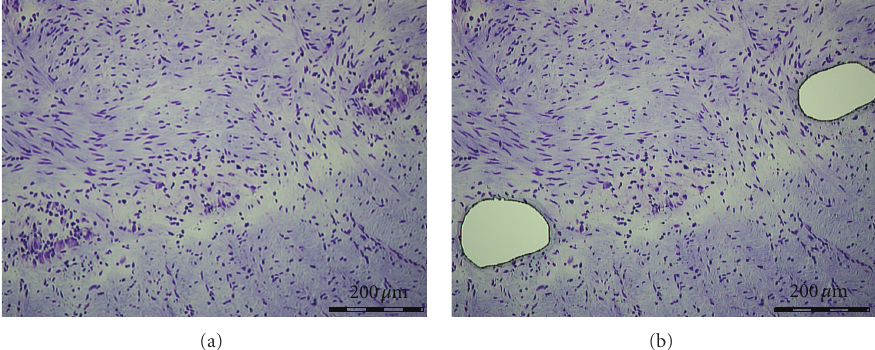
Figure 1: Myenteric plexus before and after microdissection (Cresyl violet, × 50).